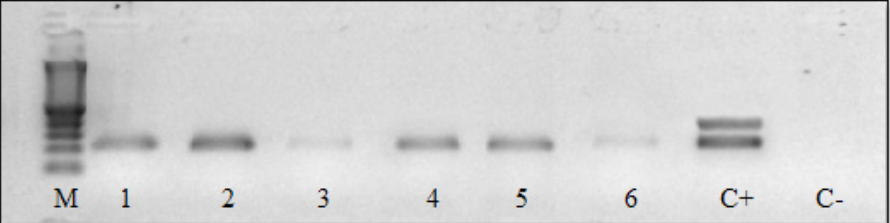
Fig 1. Agarose gel (2%) showing duplex Nosema apis and N. ceranae PCR products. M: 100 bp marker. Column 1- 6: samples showing N. ceranae amplification. Column C+: Positive control – Nosema ceranae (218 bp) and Nosema apis (321 bp). Column C-: Negative control.